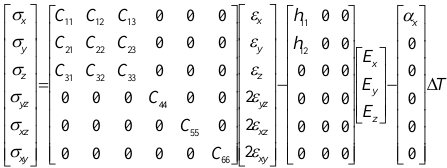
expansion coefficients, dielectric, and pyroelectric,